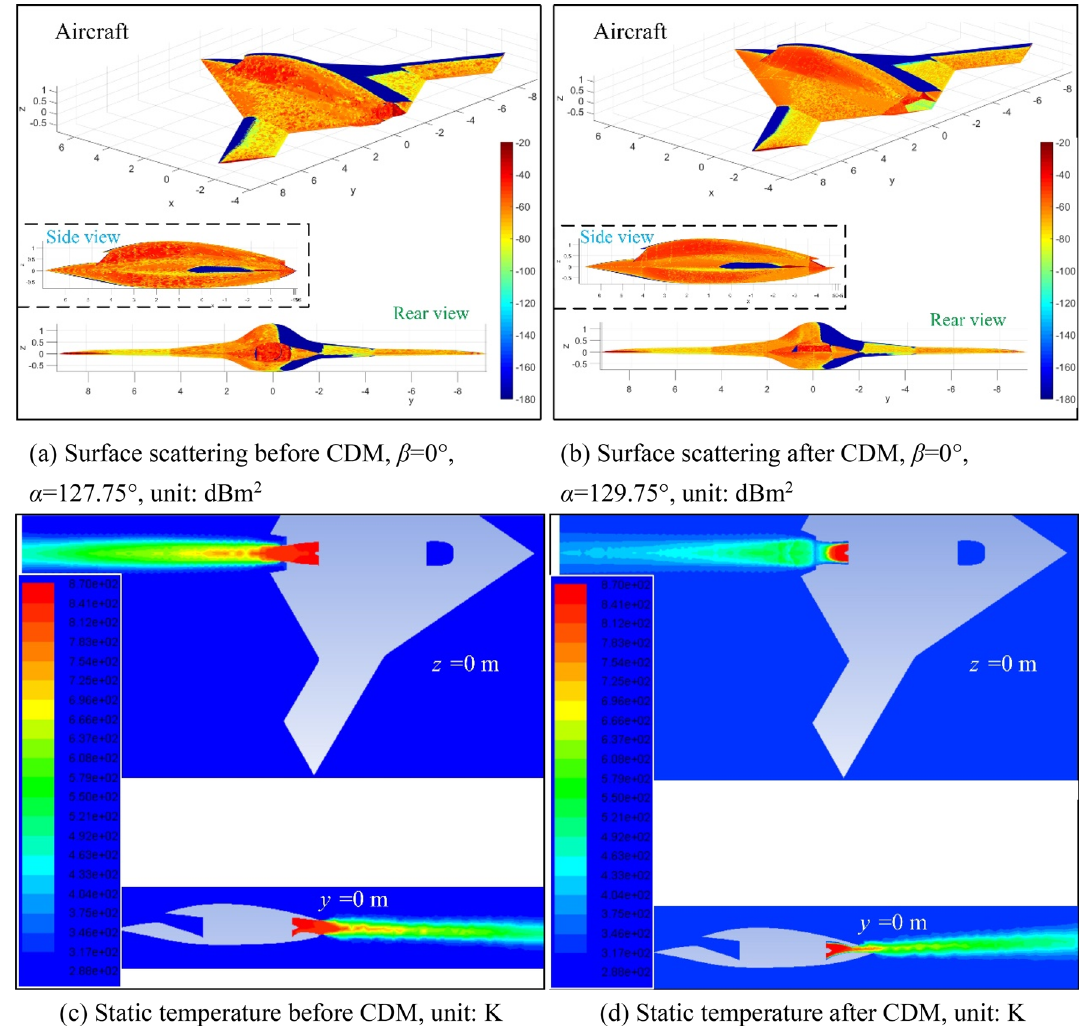
Figure 17. Performance comparison of the aircraft before and after CDM, drawn using Microsoft Visio 2007 and MATLAB